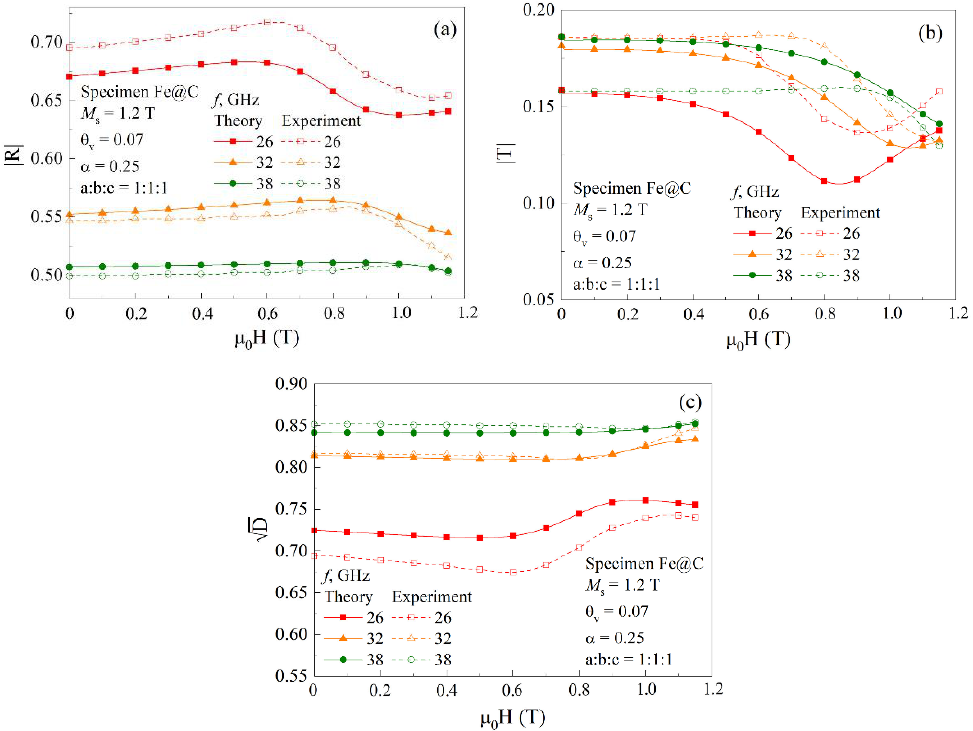
Figure 12. Comparison of the calculated and measured dependences of the reflection ( a ), transmis- sion ( b ) and dissipation ( c ) coefficients for the composite containing 7% spherical ferromagnetic particles at the frequencies of 26, 32, and 38 GHz.